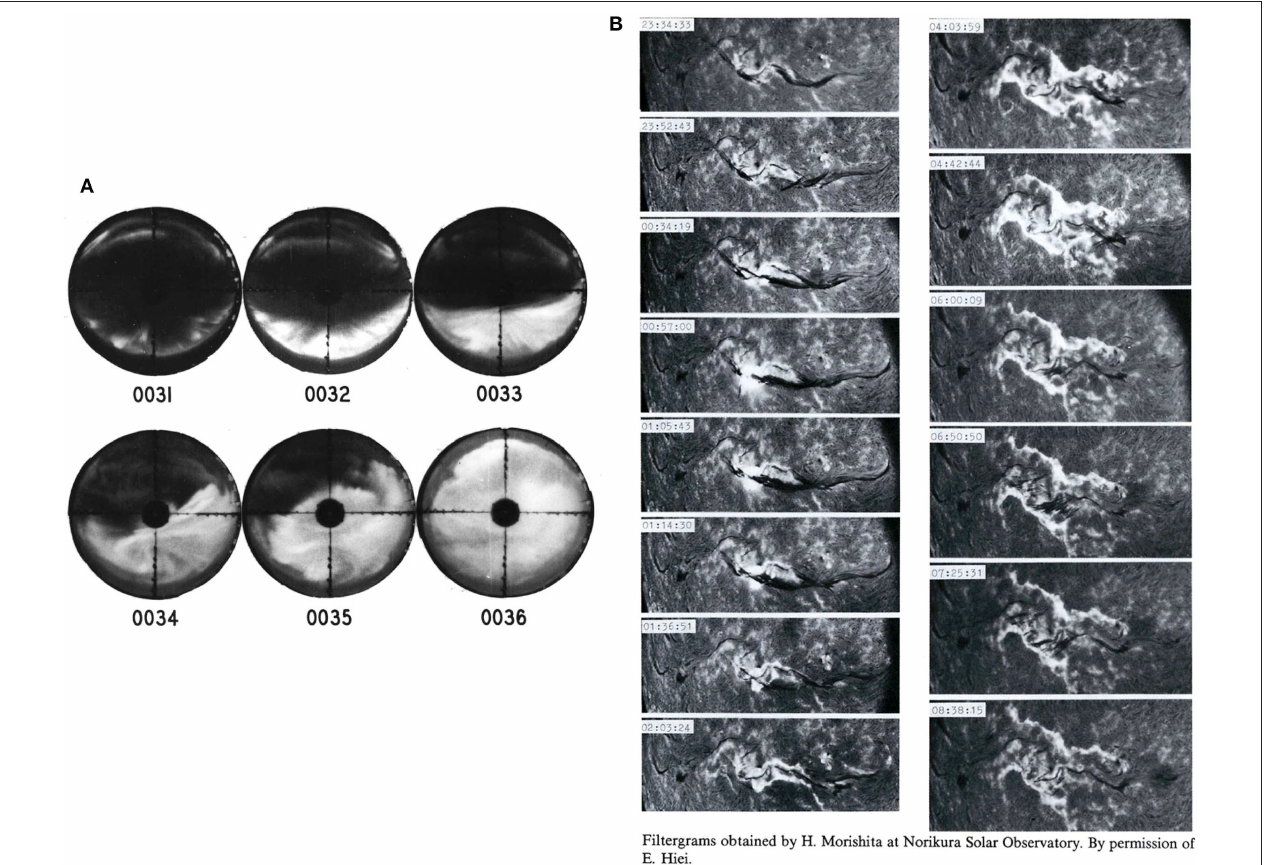
FIGURE 10 | Examples of the explosive features. (A) A series of all-sky images showing a rapid poleward advance of auroral arcs (00:31–00:36 UT); the top of the circular images points northward. (B) A typical flare; the first column (22:24 UT–[next day] 02:03 UT) is the pre-flare condition, while the second column (04:03–08:30 UT) shows the explosive phase; note the development of the two ribbons and the disturbed dark filament (the Norikura Solar Observatory, courtesy of E. Hiei).